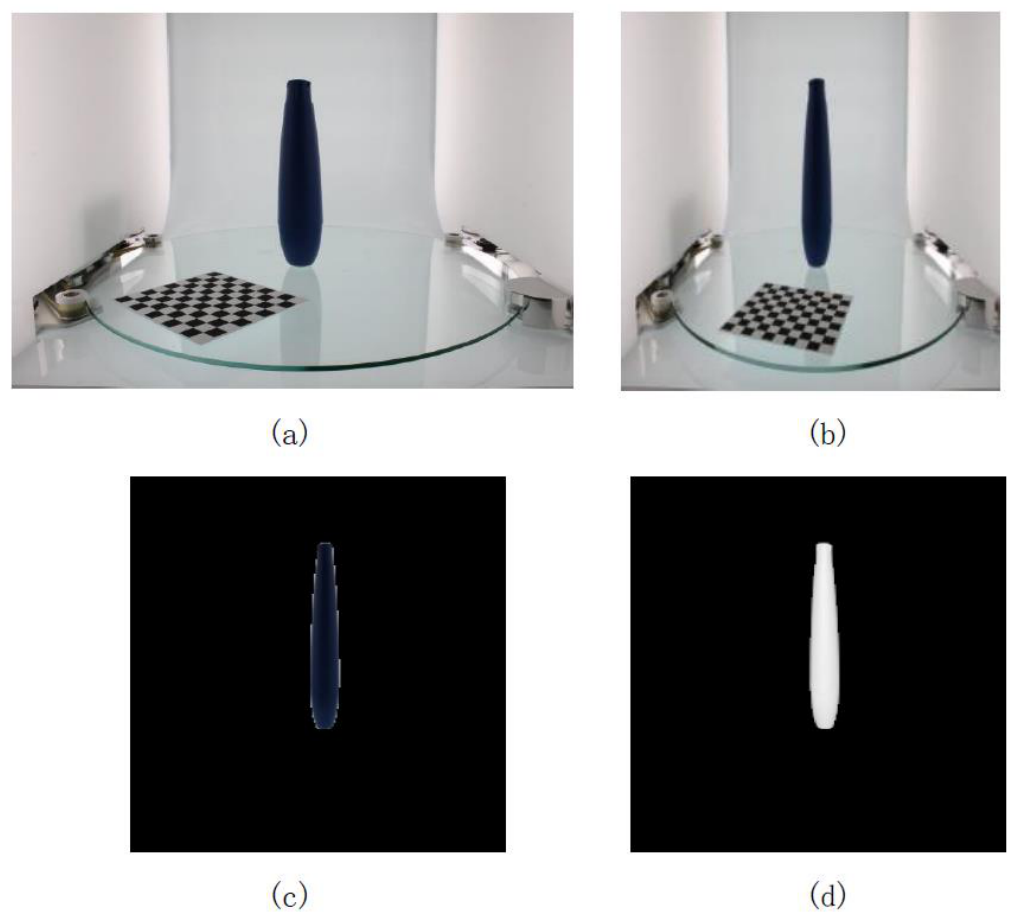
Figure 5. ( a ) Original image with 4272 × 2848 pixel; ( b ) image after resizing to 224 × 224 pixel; ( c ) segmentation results based on GrabCut; ( d ) binarization results of the mask.